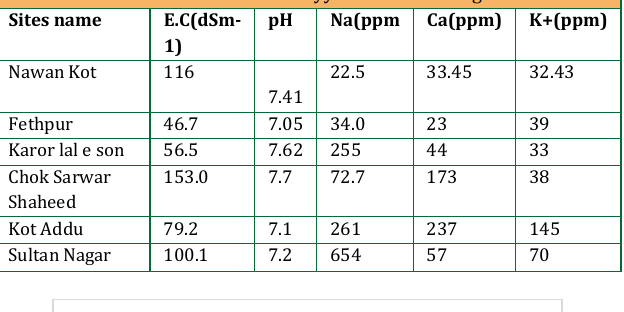
Figure 17: pH values of soil samples of Layyah and Muzaffargarh sites.